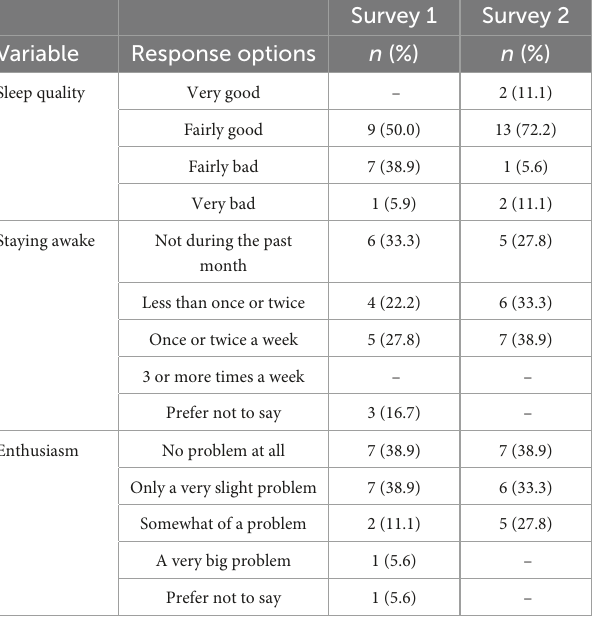
TABLE 4 Self-reported sleep quality and daytime dysfunction in Survey 1 and Survey